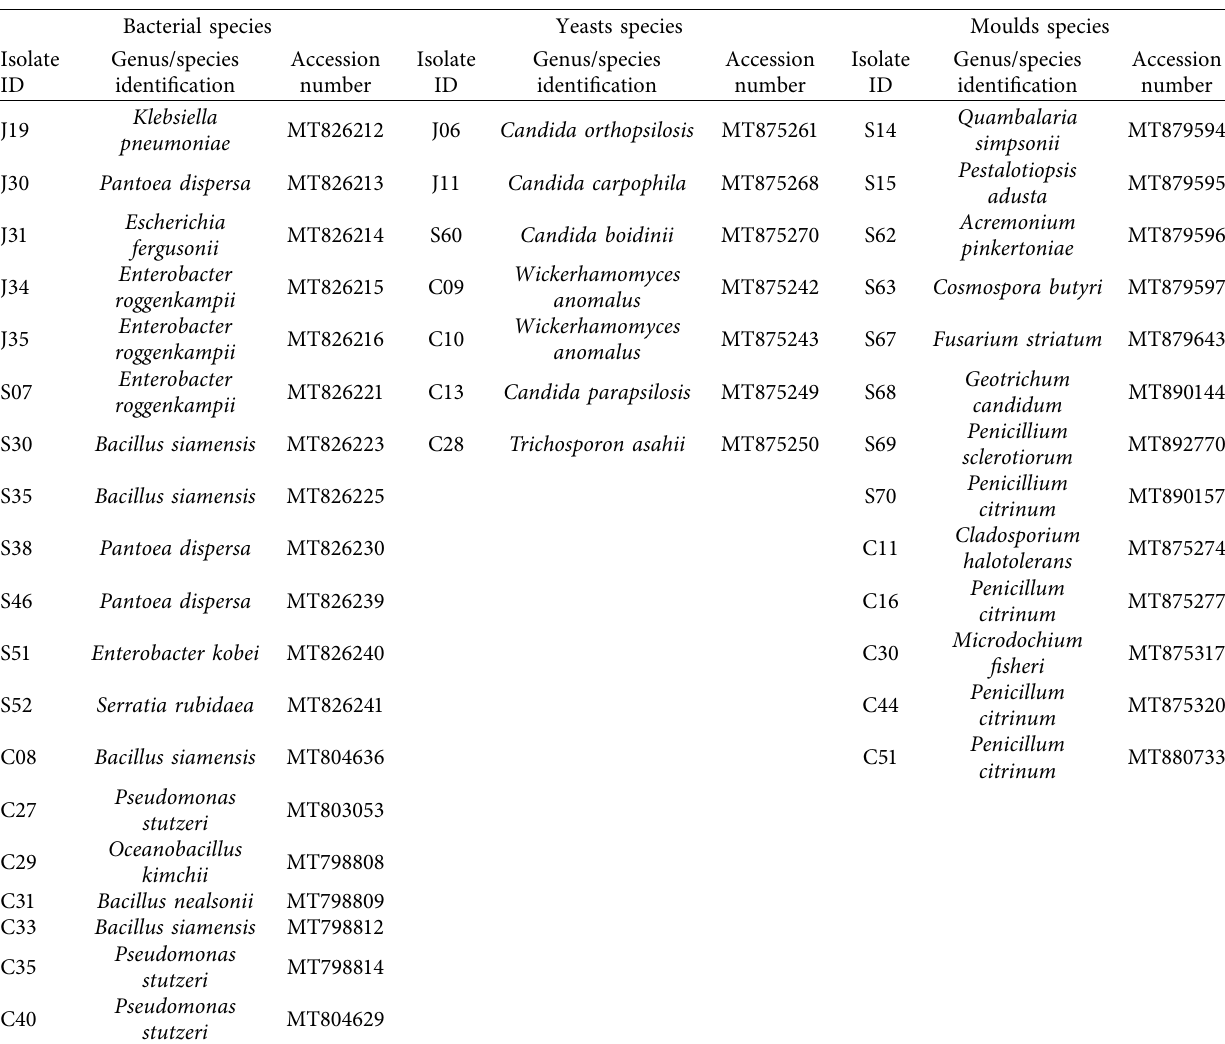
Table 5: King coconut water-associated microorganisms identified in this study with respective GenBank accession numbers. Bacterial species Yeasts